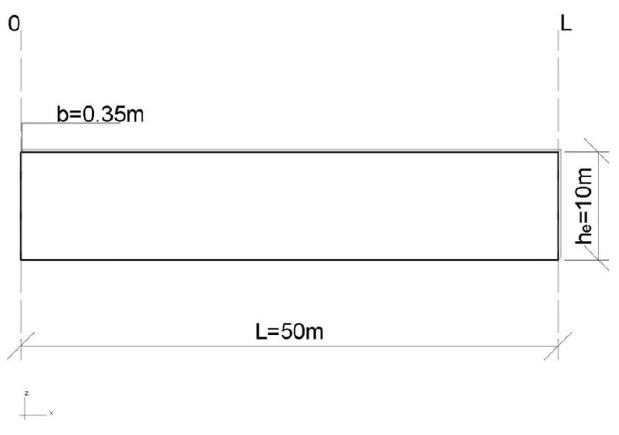
Figure 3. Test case—start geometry.